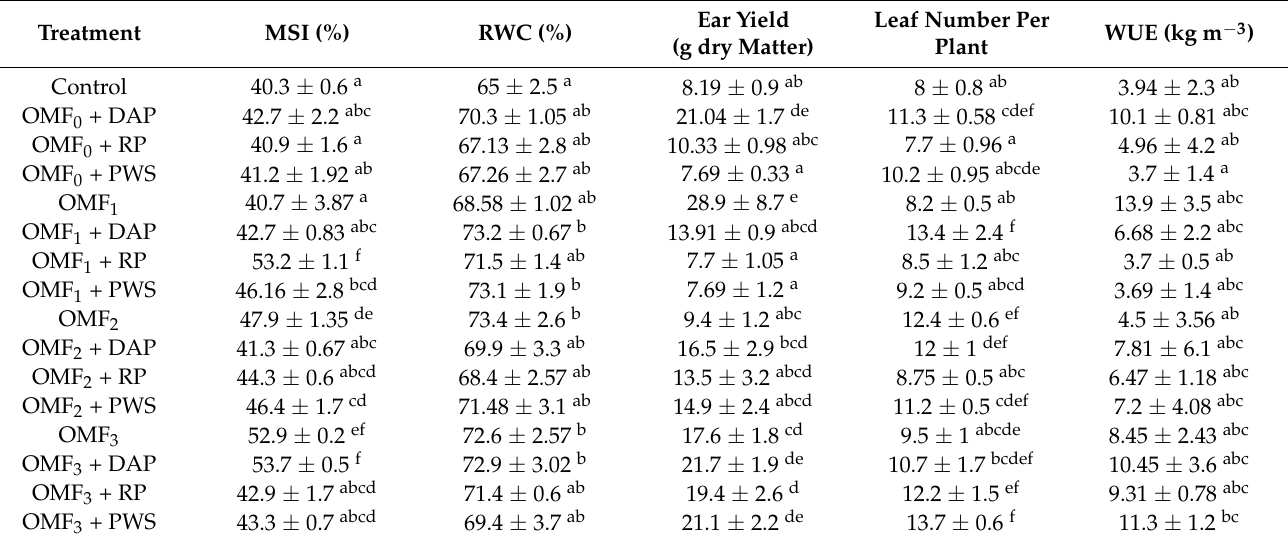
Table 4. Effect of organo-mineral applications on maize agro-physiological